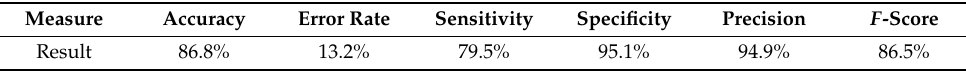
Table 10. Evaluation measures for the SURF algorithm over the 1500 patches.